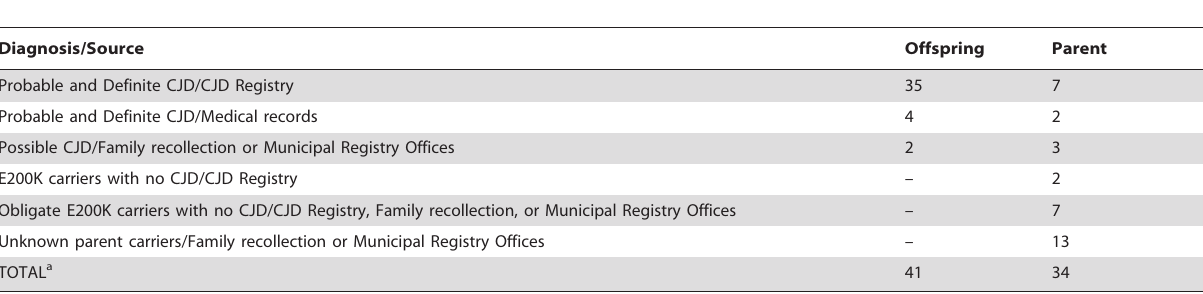
Table 1. Source of diagnostic information in offspring and parent subjects.